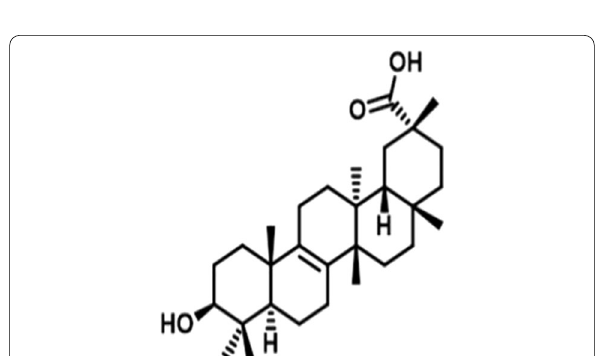
Fig. 5 Bryonolic acid (BA) 3β-hydroxy-D:C-friedoolean-8en-29-oic